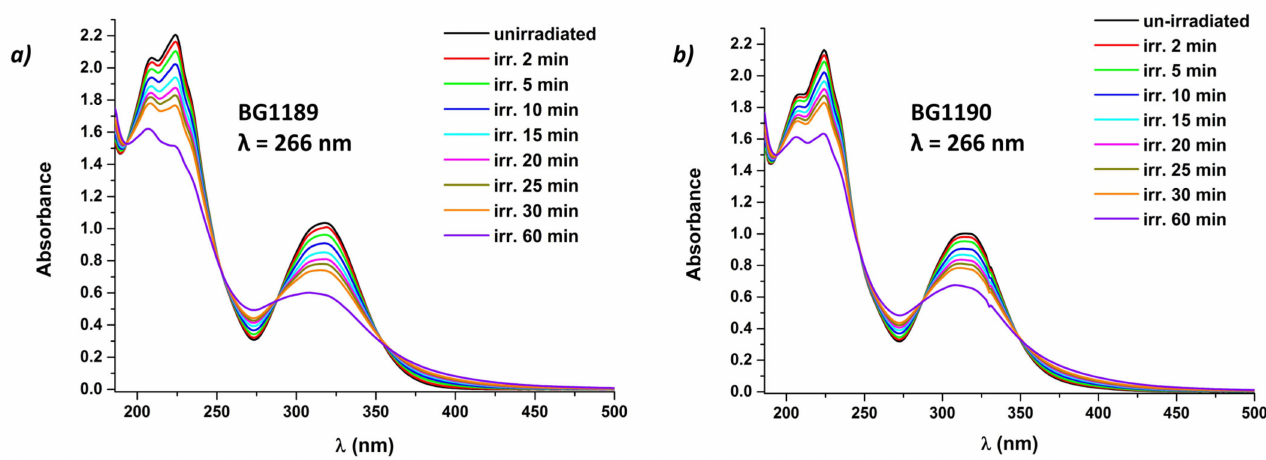
Figure 6. Laser induced modifications of the absorption spectra of: ( a ) BG1189 and ( b ) BG1190. Solutions prepared in ultrapure water at 10 − 3 M. Laser irradiation conditions: E = 6 mJ, λ = 266